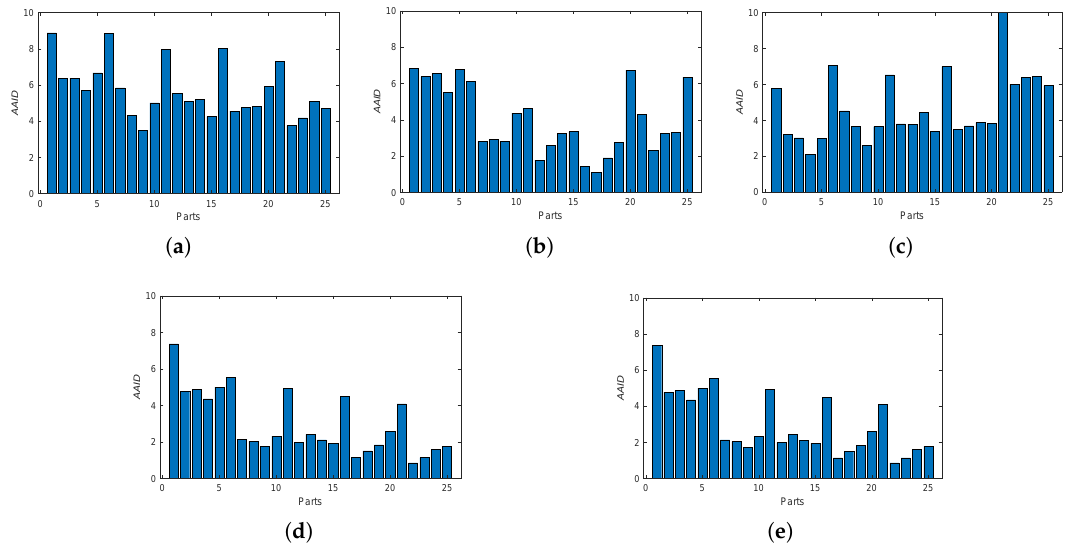
Figure 20. Spatial partition of the AAID evaluation for Hestain image. ( a ) MI. ( b ) PSNR. ( c ) NCC. ( d ) Proposed (Demp). ( e ) Proposed